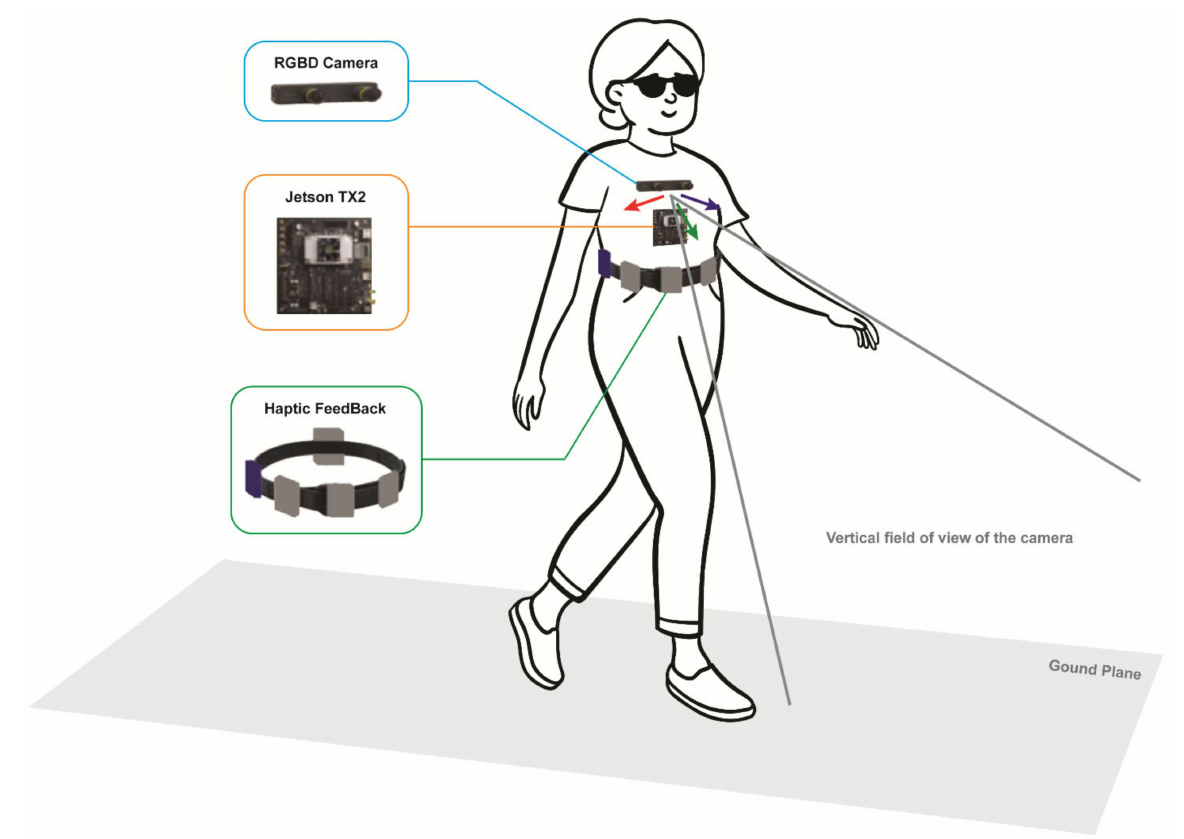
Figure 6. Camera and GPS navigation system with haptic feedback